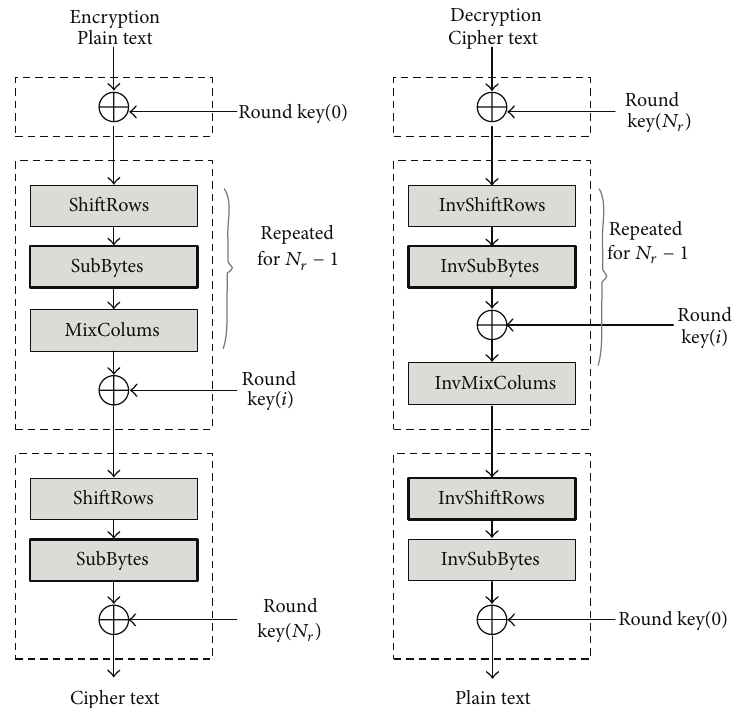
Figure 1: The encryption and decryption processes in